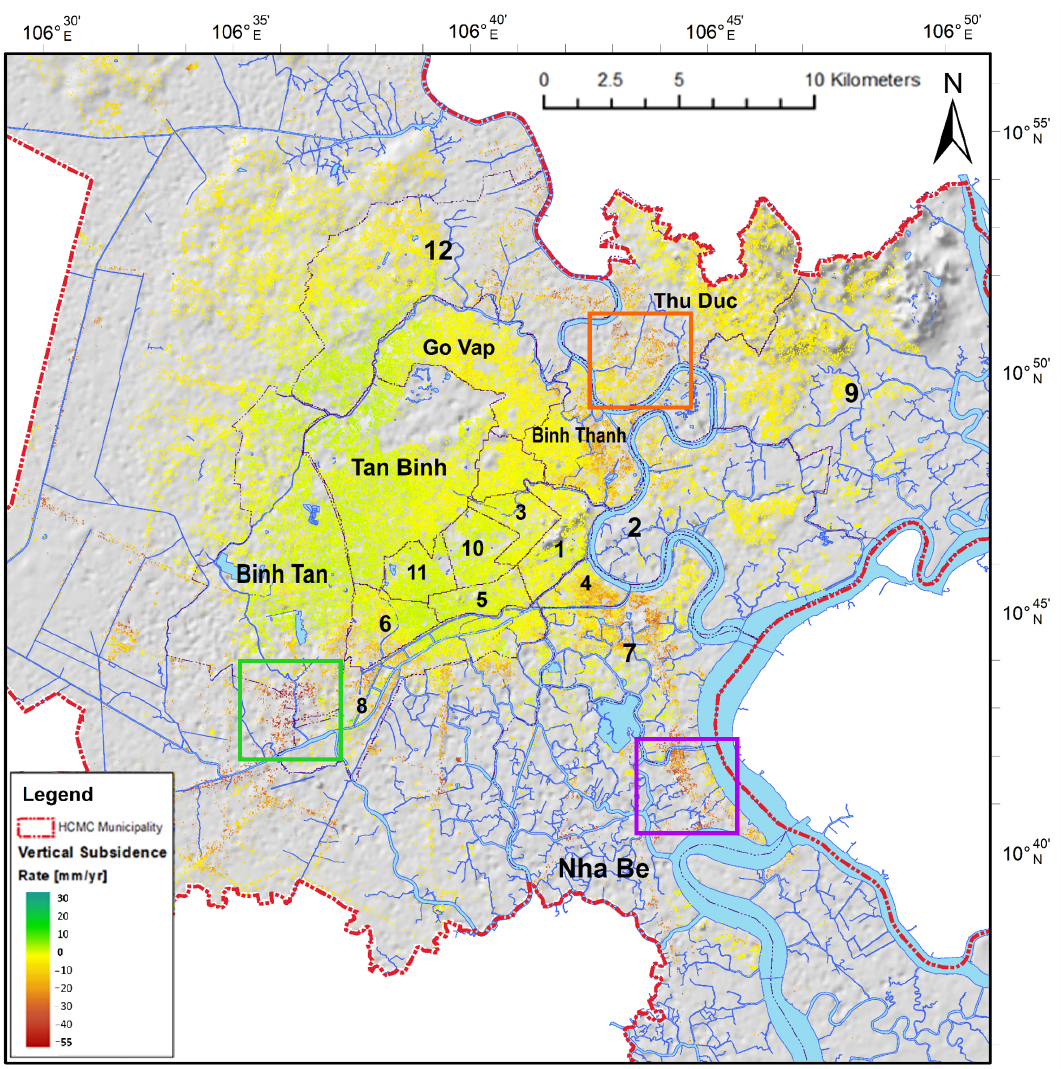
Figure 6. Average vertical subsidence rates for the period of January 2016 to June 2019. A hillshade of the 90 m res CoastalDEM is the background and an orthophoto for spatial context around HCMC. Colored boxes delineate the locations for reference in later